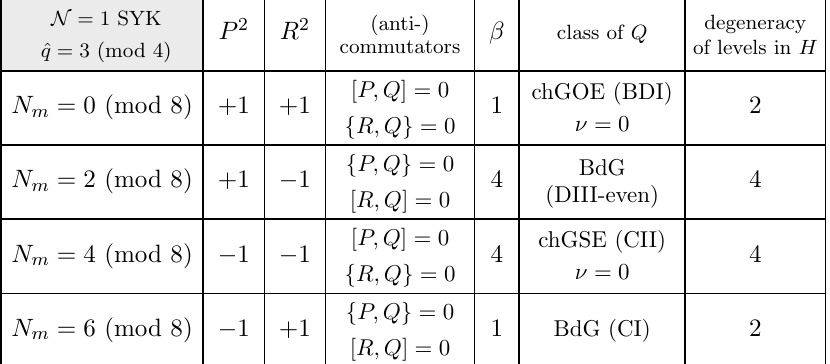
Table 5 . Symmetry classi(cid:12)cation of Q in the N = 1 SYK model for ^ q = 3 (mod 4). This table is consistent with [72]. For the block structure of each class we refer to table